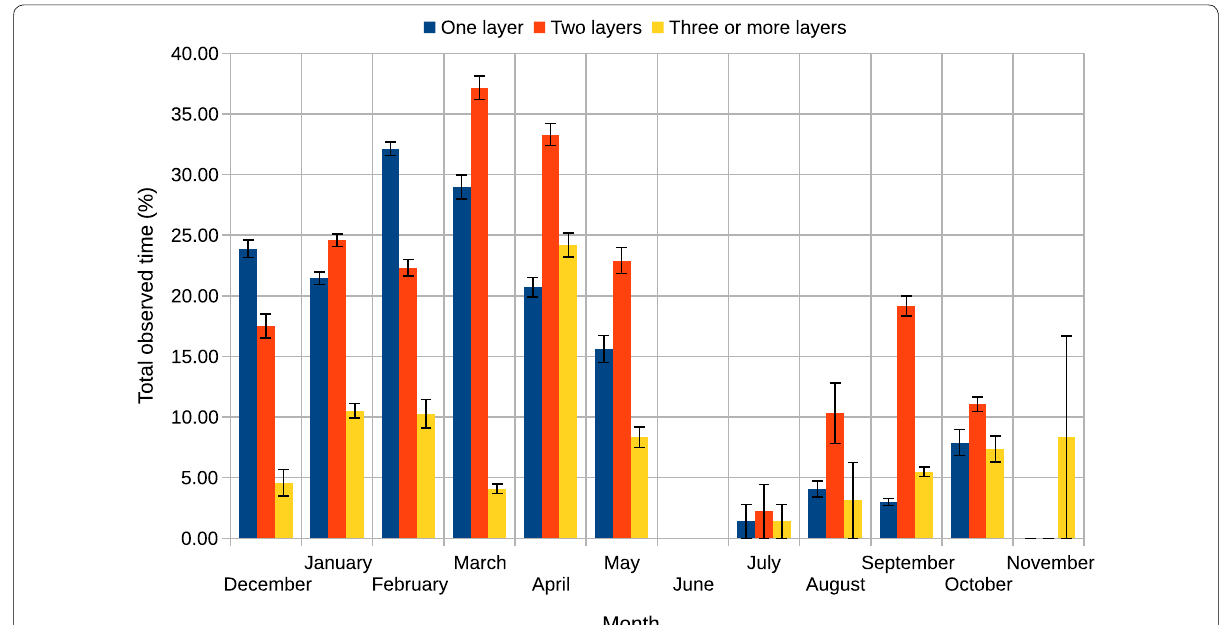
Fig. 3 Echo layer results. Year‑long statistics of atmospheric layers. One (L1), two (L2), or more than two (L3) echo layers were observed, and the percentage of time that each type of layering persisted within each month (relative to available radar time) is presented. The maximum value is reached during the dry‑season months. The rainy season shows a decrease in the number of measurable layers. Error bars represent ± 1 standard